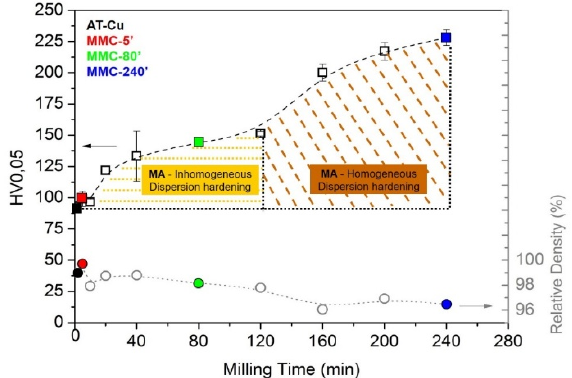
Figure 7. Hardness and relative density of the MMC sample.